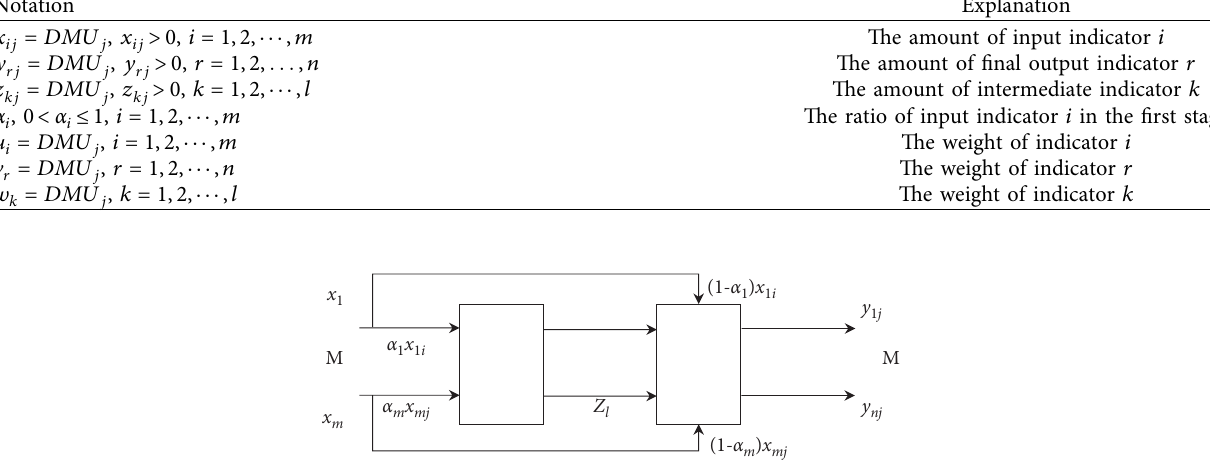
Figure 1: Production flowchart of the decision unit DMU